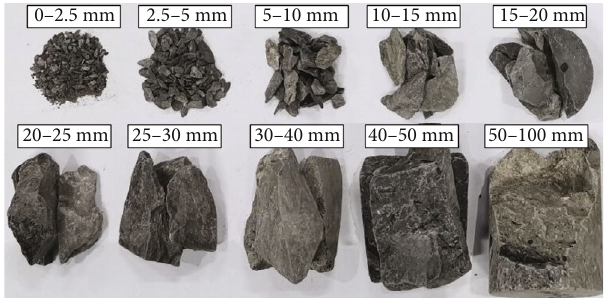
Figure 12: Distribution of broken